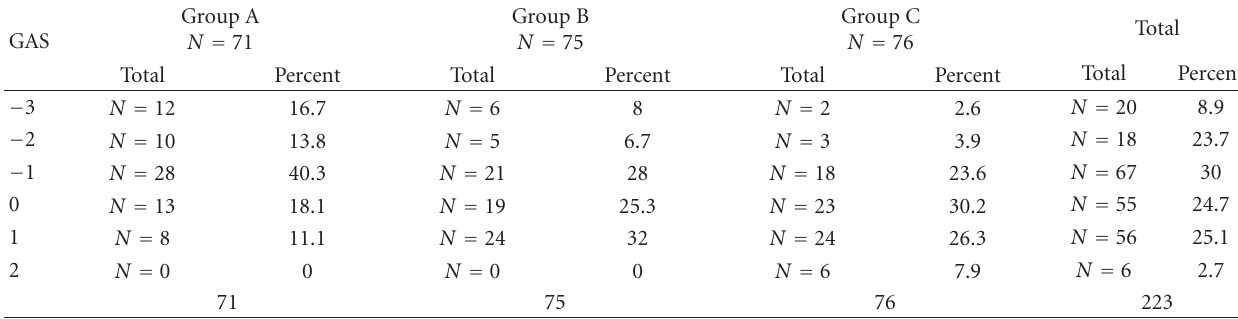
Table 8: E ff ect of the training programme on the main goals